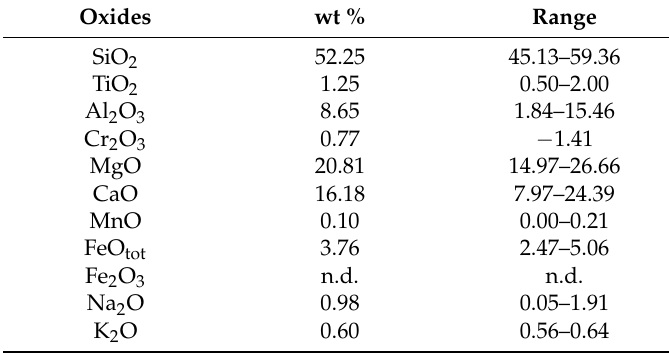
Table 2. Chemical composition obtained by electron microprobe analyses (30 analytical points) and min-max range of fibrous tremolite.